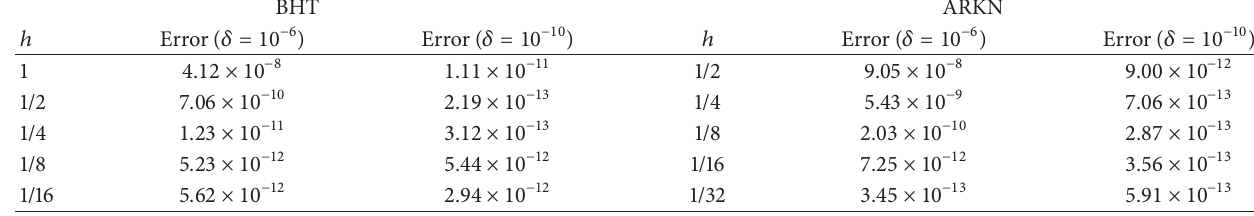
Table 6: Errors at 𝑥 = 1000 , for Example 6.